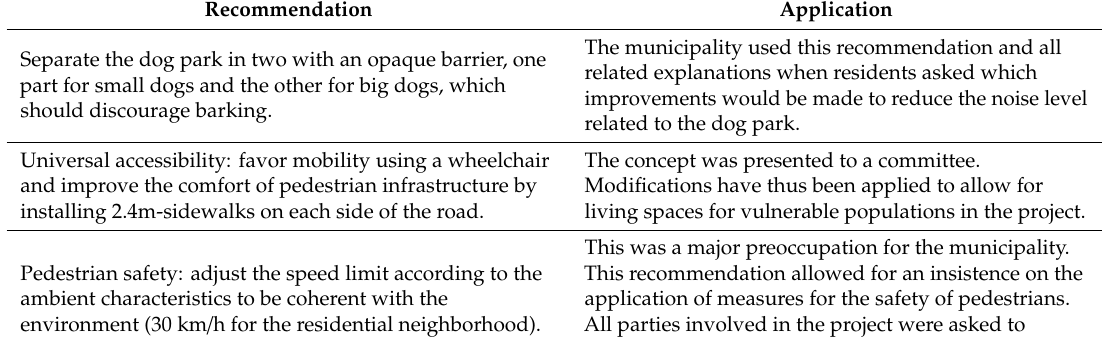
Table 2. Examples of recommendations provided in the completed HIAs and their application by the municipality. Recommendation